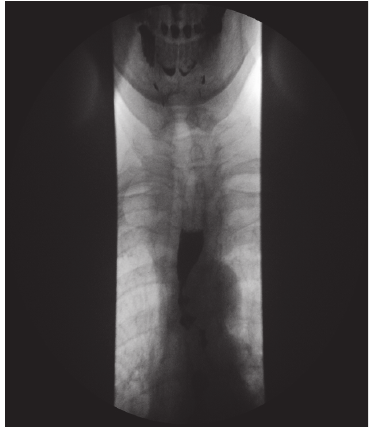
Figure 3: Corkscrew oesophagus. Barium